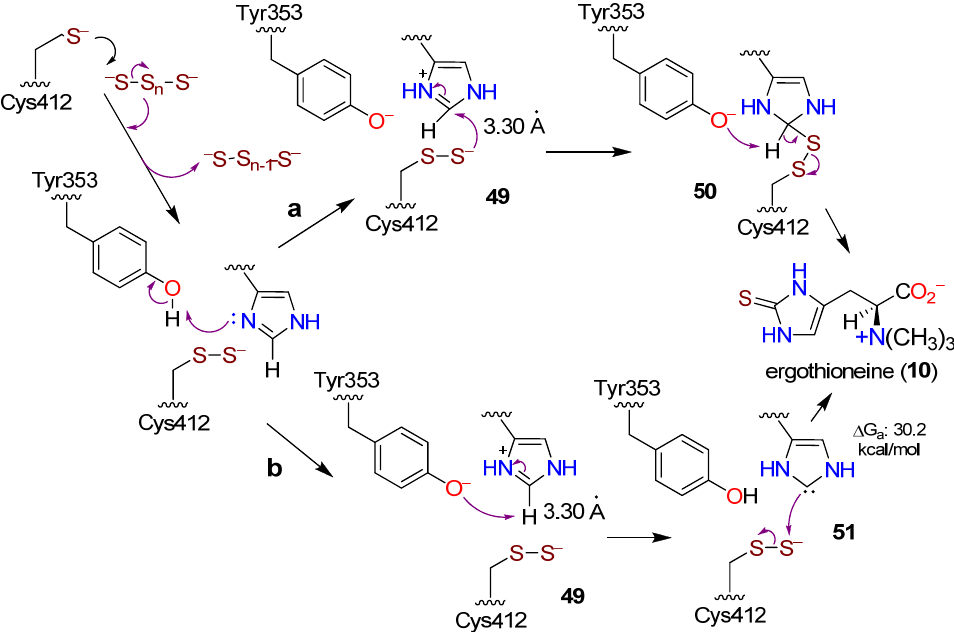
Figure 15. Proposed alternative mechanistic pathways a and b for the interaction of hercynine ( 13 ) and polysulfur in the presence of EanB to form ergothioneine ( 10 ) (adapted from ref. [162]).